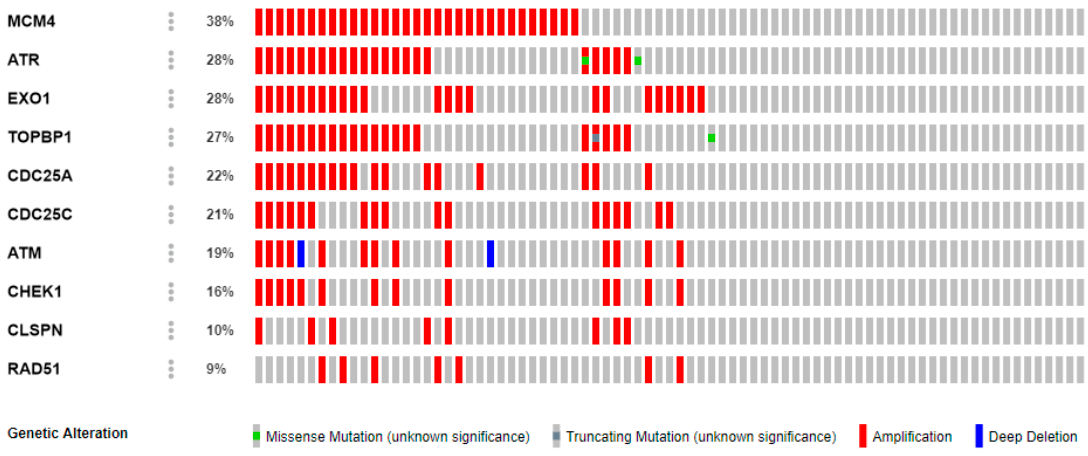
Figure 8. Prostate cancer types frequently amplify CHEK1. Genetic landscape (Oncoplot) of 10 genes in a prostate cancer (Multi-Institute, Nat Med 2016) sample. The figure is a schematic representation (Oncoplot) of the most commonly mutated genes. Each column represents a patient. Colors depict the type of mutations for each gene. Complete samples (114 patients / samples). Queried genes are altered in 51 (45%) of the queried patients / samples.